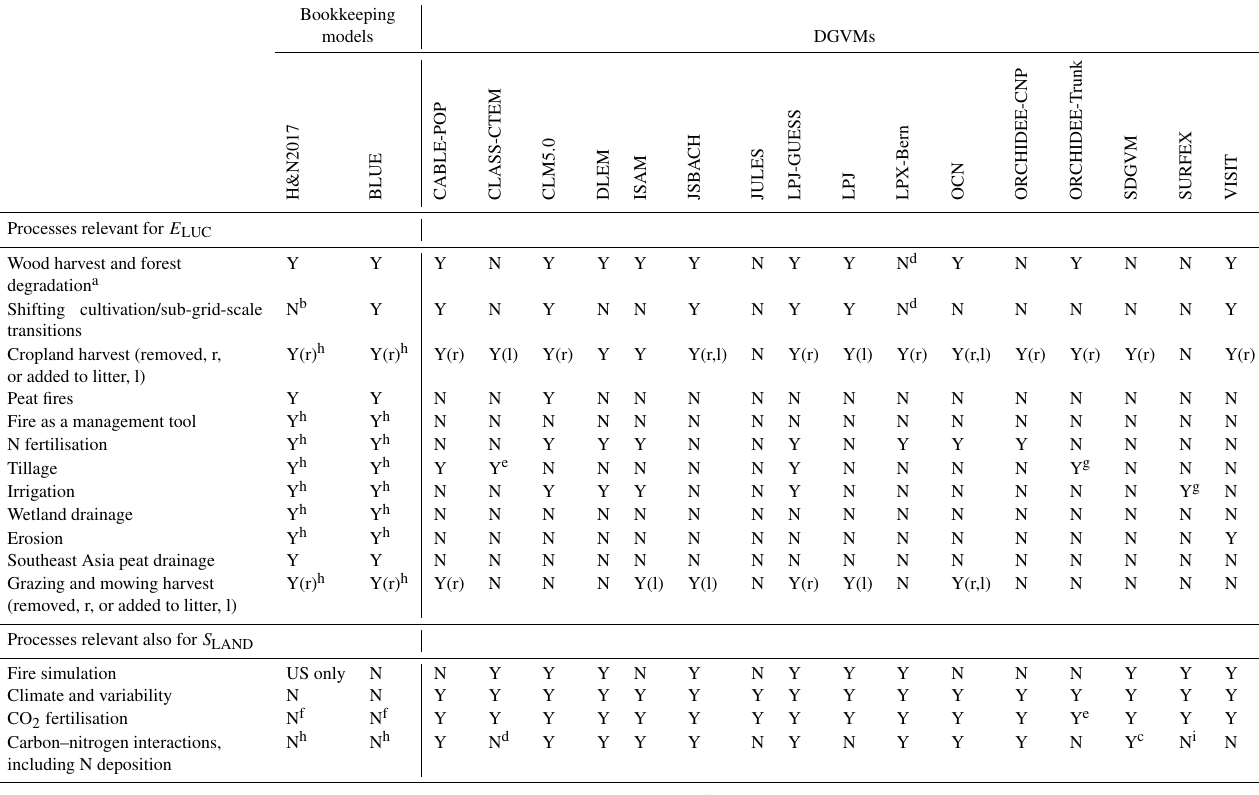
Table A1. Comparison of the processes included (Y) or not (N) in the bookkeeping and dynamic global vegetation models for their estimates of E LUC and S LAND . See Table 4 for model references. All models include deforestation and forest regrowth after abandonment of agriculture (or from afforestation activities on agricultural